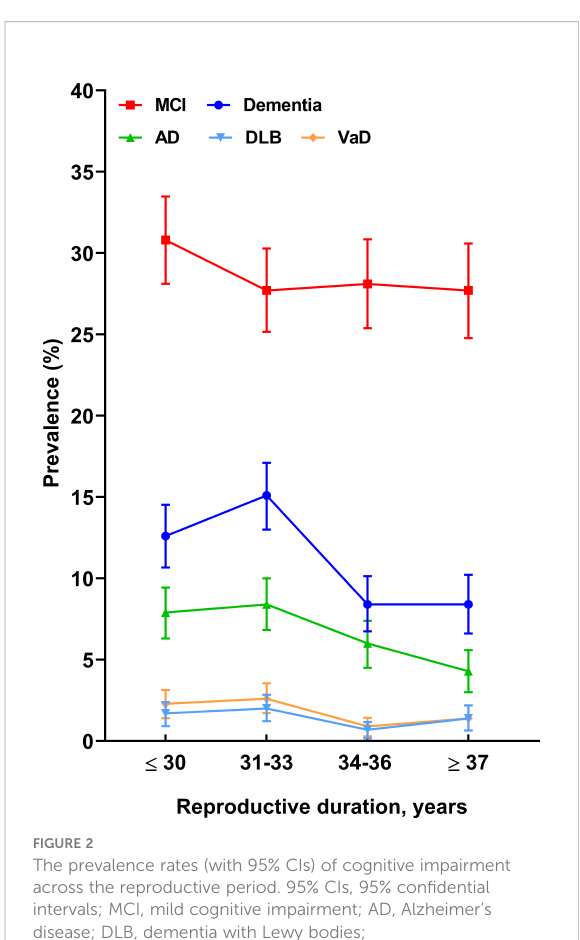
FIGURE 2 The prevalence rates (with 95% CIs) of cognitive impairment across the reproductive period. 95% CIs, 95% con fi dential intervals; MCI, mild cognitive impairment; AD, Alzheimer ’ s disease; DLB, dementia with Lewy bodies; VaD, vascular dementia.